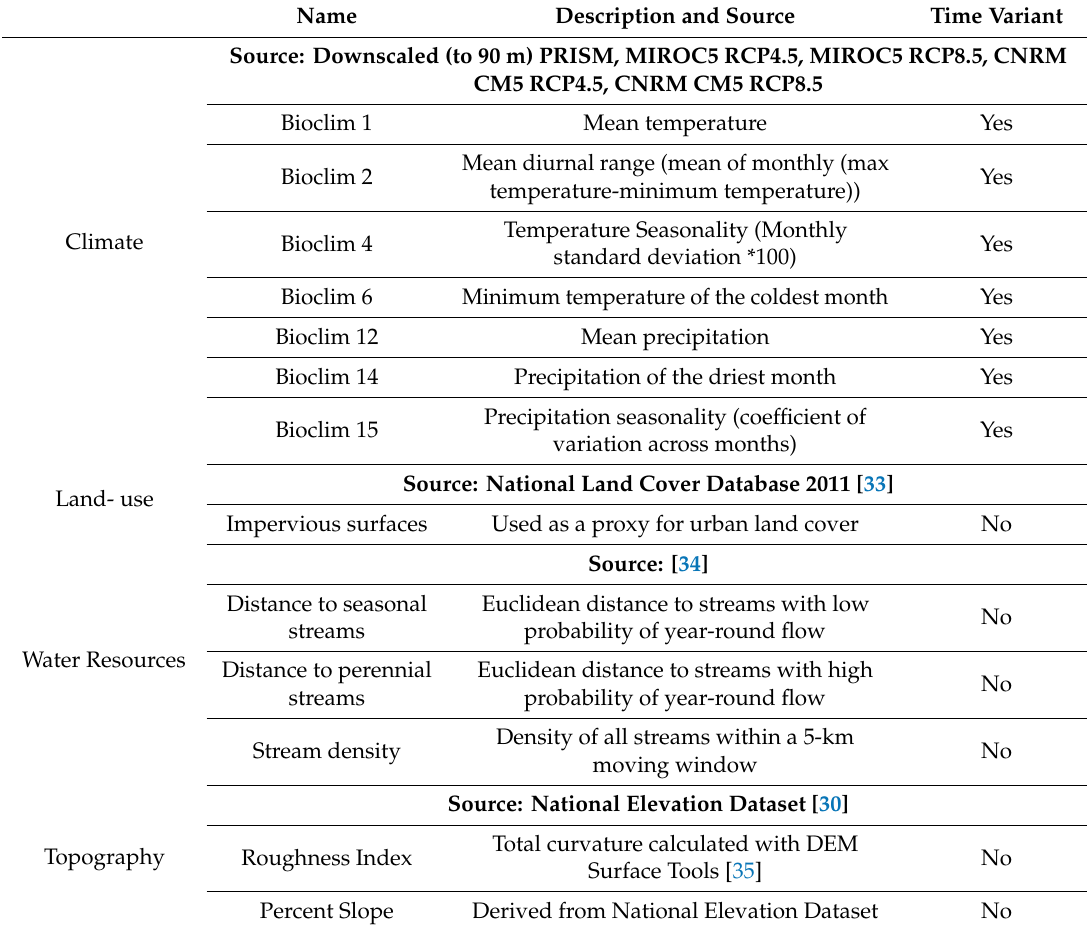
Table 1. Environmental and climatic variables used in species distribution